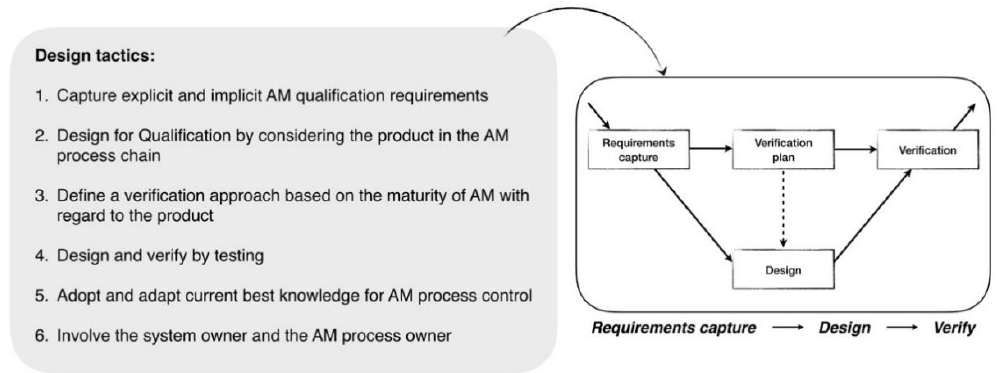
Figure 7. The six design tactics formulated based on the study with the purpose of facilitating and encouraging proactive consideration for qualification during product development with AM. The tactics are mapped onto the requirements capture, design and verify sequence to generalize a Design for Qualification framework.